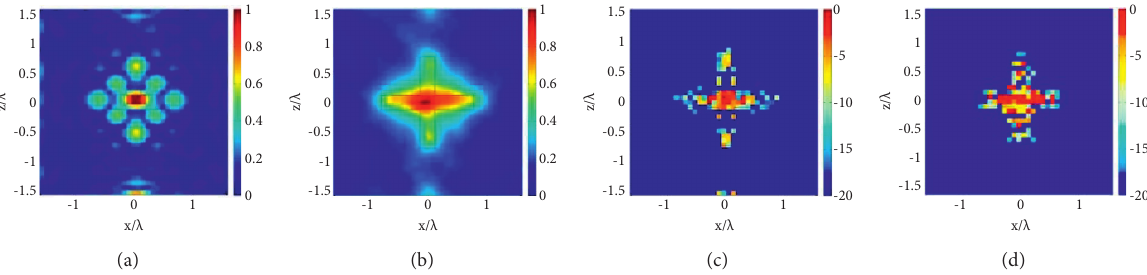
Figure 12: Reconstruction of the cross-shaped object a � 0.75 λ in xOy plane and φ -oriented dipoles. (a) TSVD, (b) LSM, (c) SSP, and (d) SHSP. SNR � 10 dB.